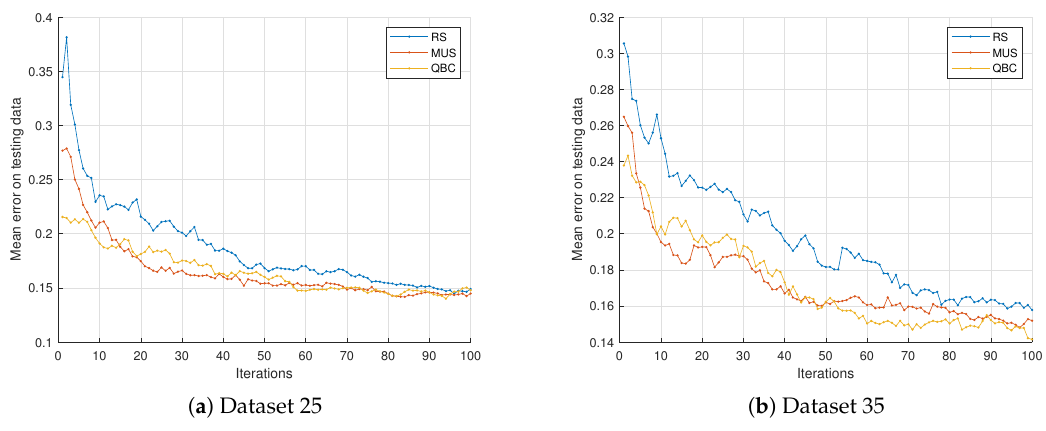
Figure 2. Mean test error during 100 iterations of the algorithm for all used